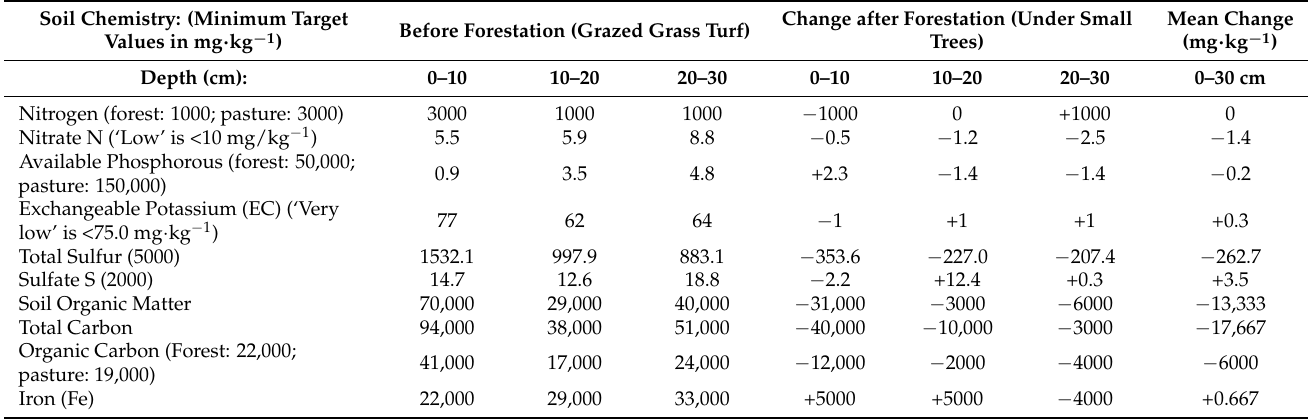
Table 1. Before and after planting: soil chemistry and target values